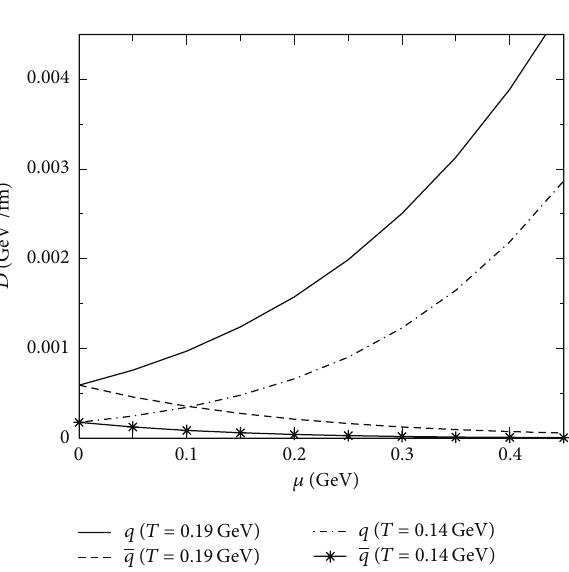
Figure 14: The same as Figure 12 for bottom quark.